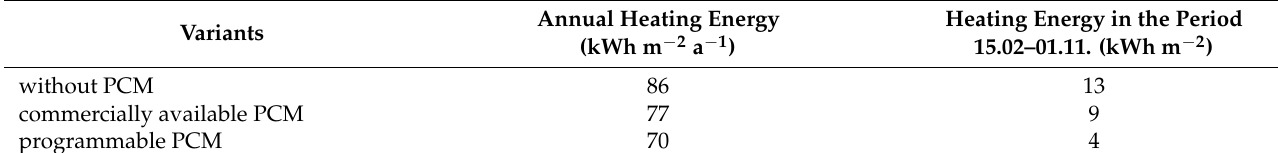
Figure 9. Comparison of the required heating energy during a year when using thermal insulation glazing without a PCM (blue), with a commercially available PCM (gray), and with a newly devel- oped, programmable PCM (green).